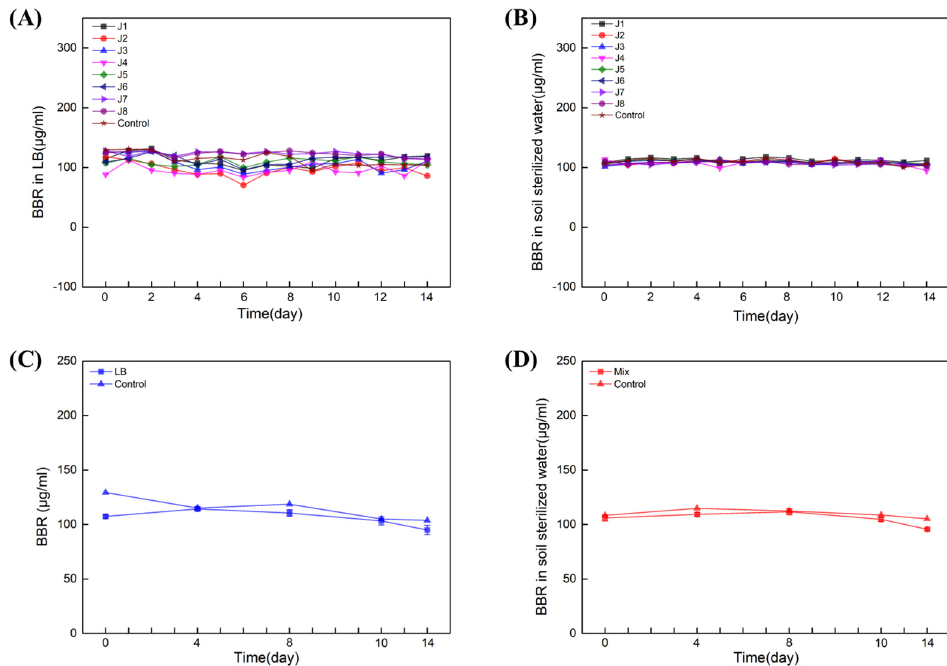
Figure 4. Eight strains failed to degrade BBR. Degradation of BBR by J1 − 8 in LB: Experiments with single ( A ) and multiple ( C ) degradations. Degradation of BBR by J1 − 8 in soil sterilized water: Experiments with single ( B ) and multiple ( D ) degradations. Biological replicates were conducted for three times.